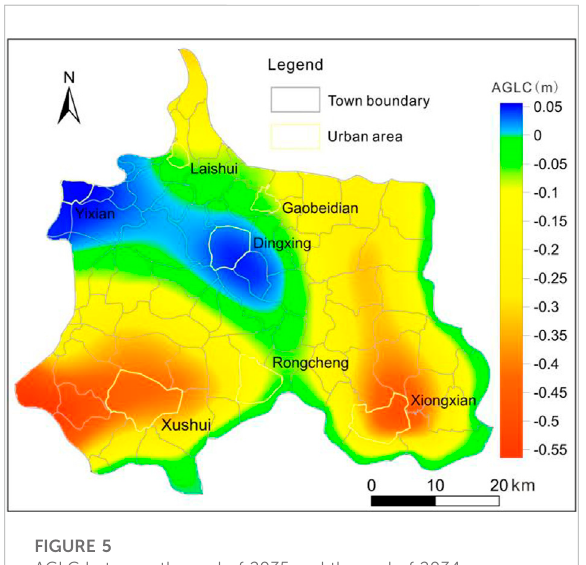
FIGURE 5 AGLC between the end of 2035 and the end of